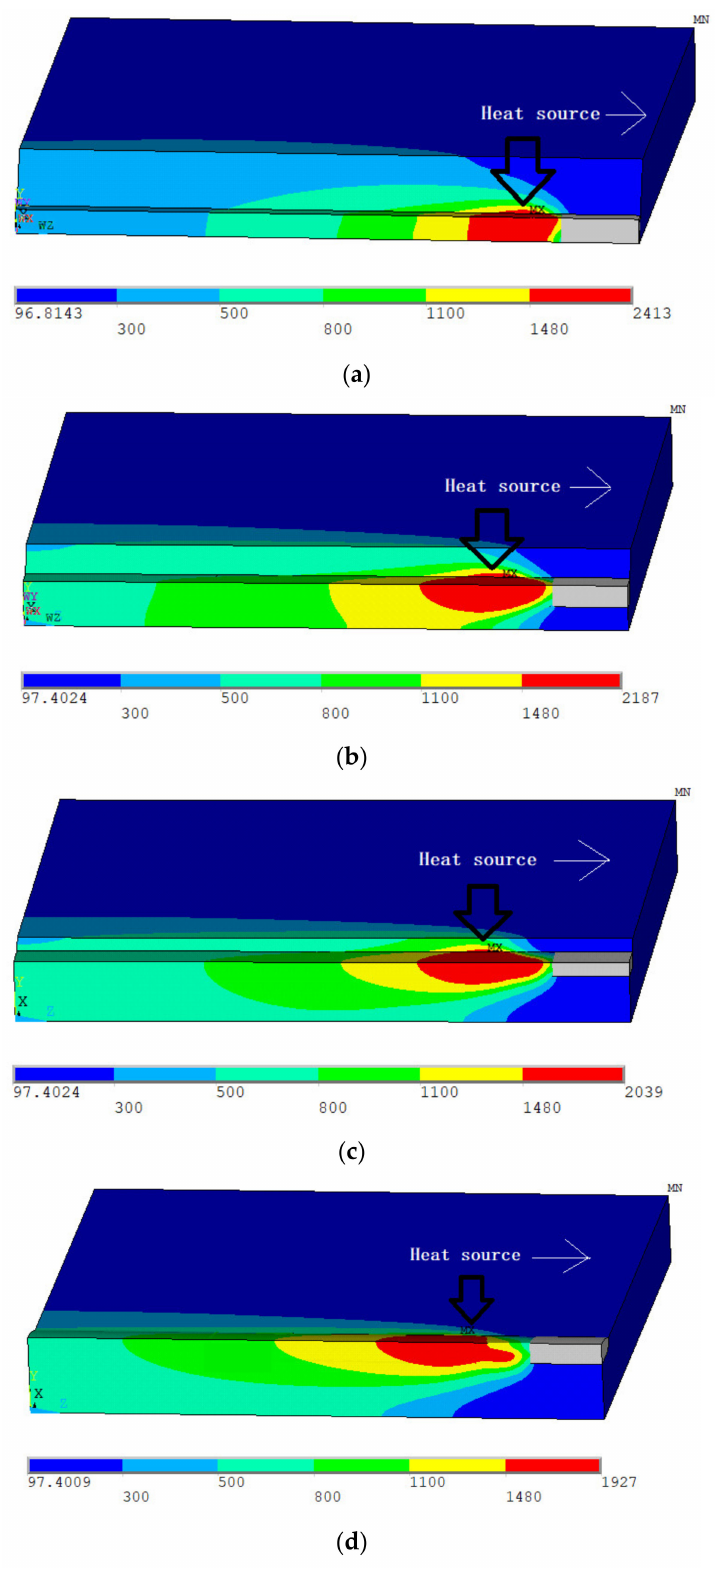
Figure 10. Calculated temperature fields: ( a ) backing welding, ( b ) first layer welding, ( c ) second layer welding, and ( d ) third layer